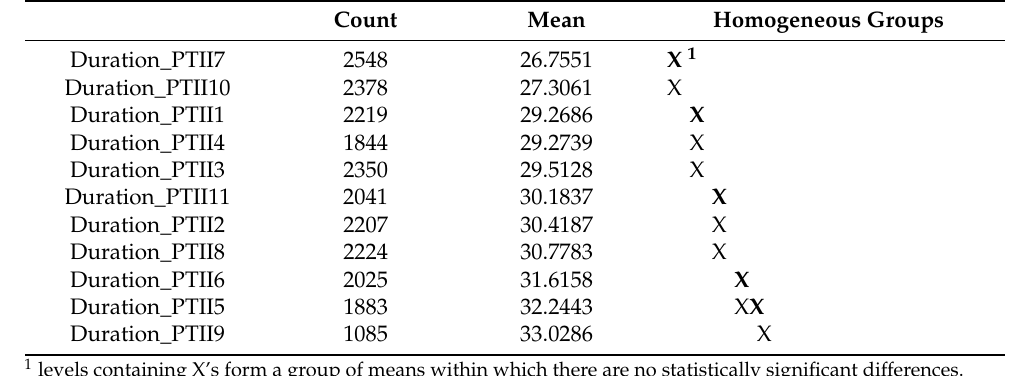
Table 3. Multiple range test